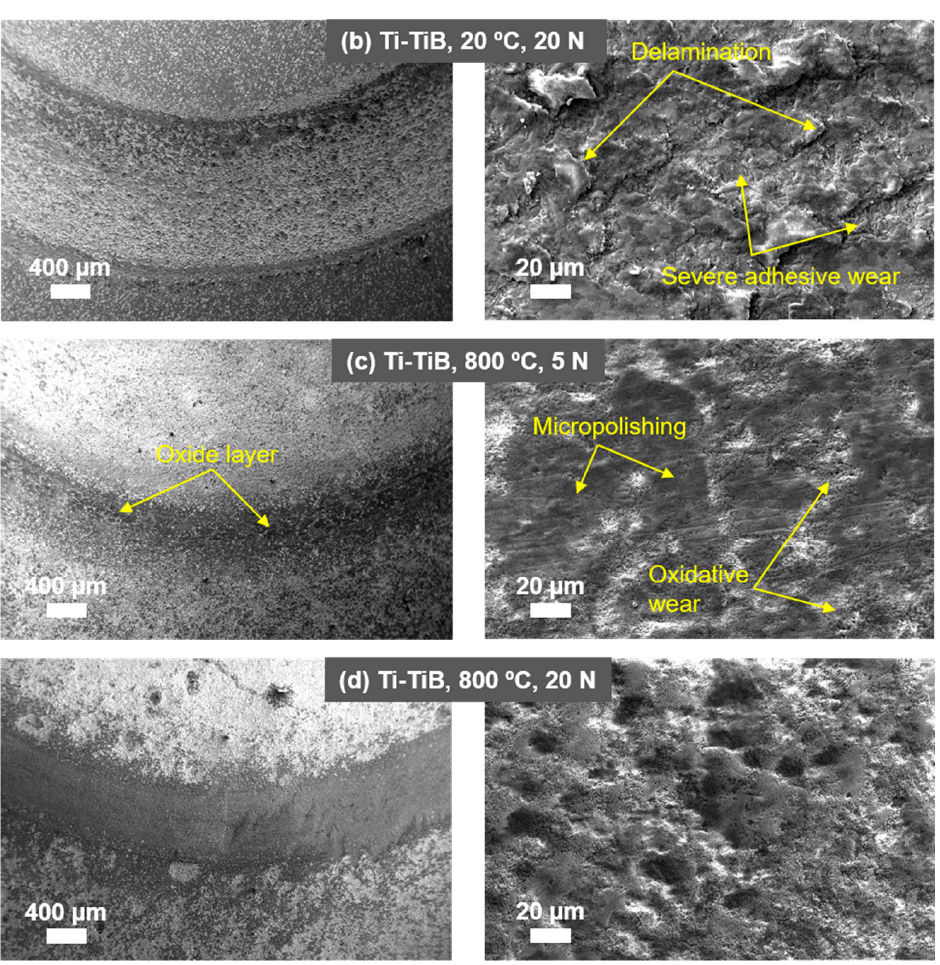
Figure 6. SEM images of composite surfaces with different magnification taken after sliding test. The test conditions are indicated in the figure.